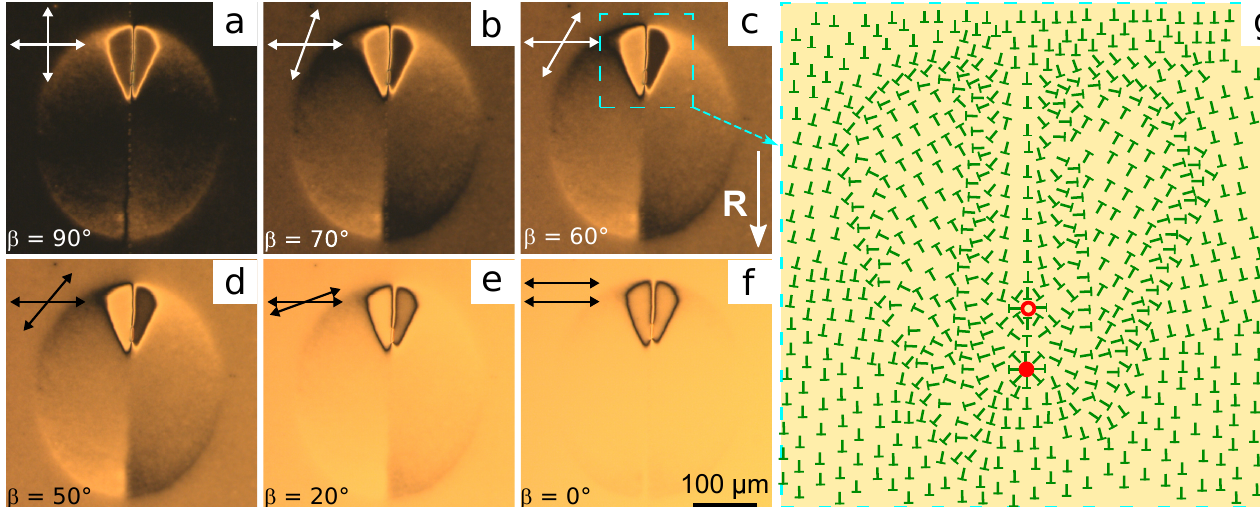
Figure 7. POM photos of the sample area with substrate covered with PiBMA:PMMA: LN-396 = 80:20:20 mixture after collapsing of the domain under the action of voltage U = 10 V are taken at the angle between the analyzer and polarizer β equal to: ( a ) 90 ◦ , ( b ) 70 ◦ , ( c ) 60 ◦ , ( d ) 50 ◦ , ( e ) 20 ◦ , and ( f ) 0 ◦ . ( g ) The scheme of director orientation in the area with a significant deformation. The boojums with topological charges − 1 and + 1 are indicated by the red unpainted and painted circles,